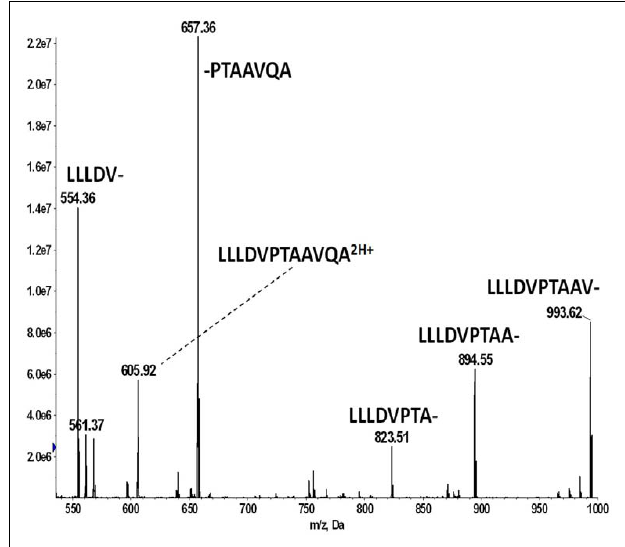
FIGUREA12 | MS 2 605.8 spectrum of synthetic peptide LLLDVPTAAVQA.